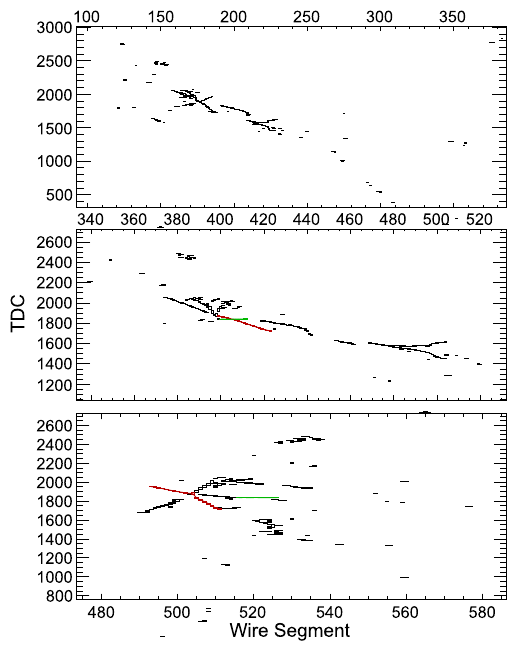
Fig. 37 Event display for a NC DIS interaction initiated by an atmo- spheric neutrino. The vertical axis is TDC value, and the horizontal axis is wire number. The bottom view is induction plane one, the middle is induction plane two, and the top is the collection plane. This event mim- ics the n − ¯ n signal topology by having multi-particle production and electromagnetic